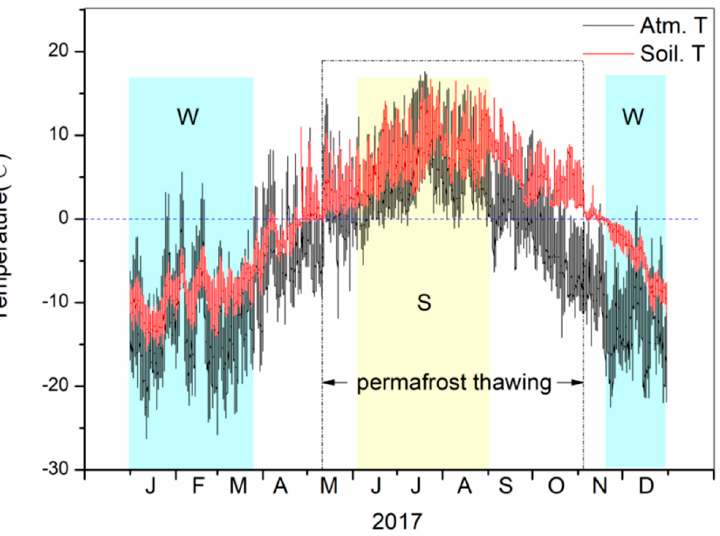
Figure 3. Daily temperature curves of low-level air and soil active layer in the Muli permafrost of the Qilian Mountains from January to December in 2017.